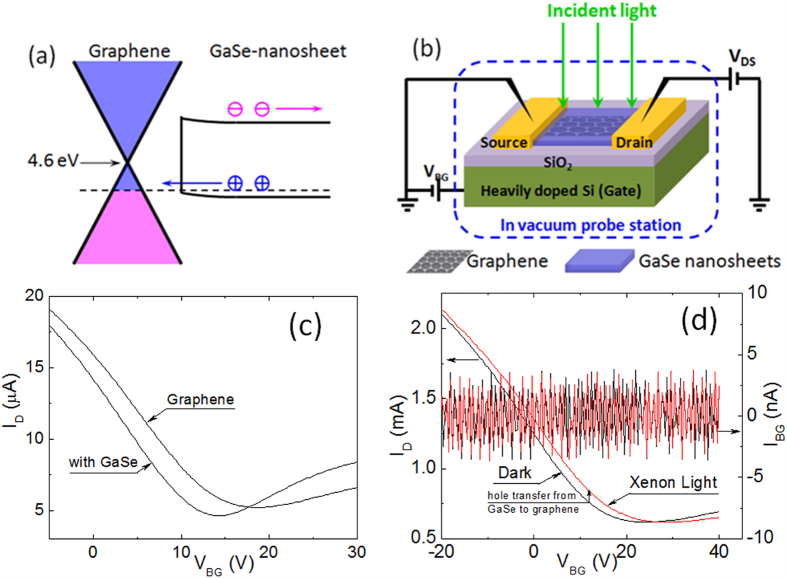
(a) Schematic graphene/GaSe-nanosheet interface band diagram; (b) Illustration of the graphene/GaSe-nanosheet hybrid GFET and measurement setup; (c) ID vs. VBG curves of GFET with/without GaSe nanosheets in dark, VSD = 10 mV. (d) GFET transport property of ID vs. VBG and IBG vs. VBG curves in dark and under 155 mW/cm2 Xenon light illumination; VSD = 1 V.